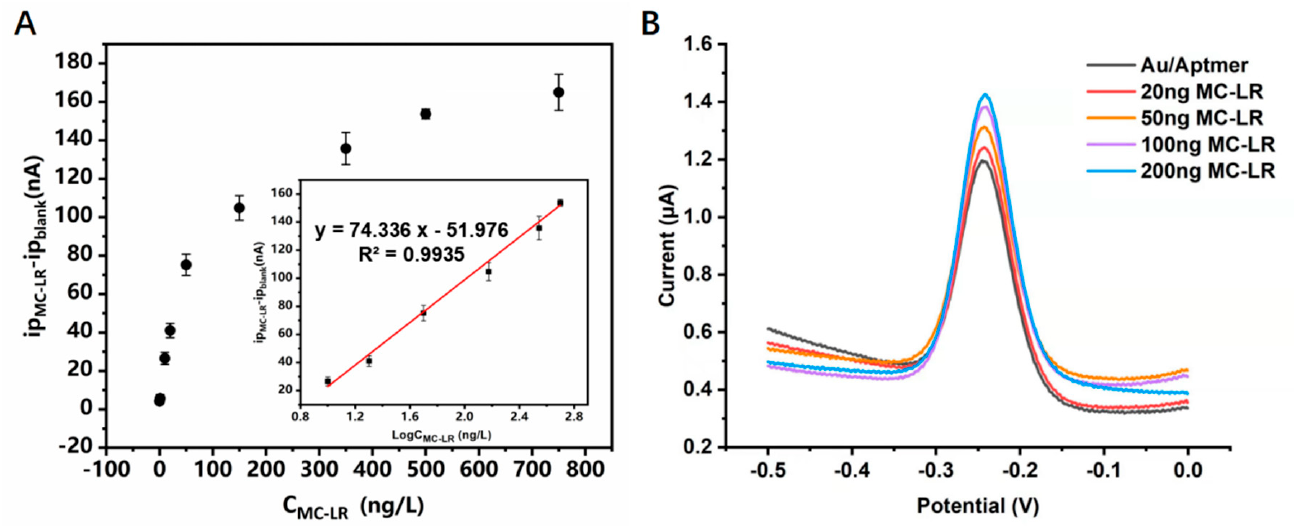
Figure 4. ( A ) Calibration curves for the electrochemical sensor obtained in SWV. The inset depicts the linear dynamic range, the slope (sensitivity), and the correlation coefficient (R 2 ). ( B ) SWVs of the E − AB sensor in different concentrations of MC − LR